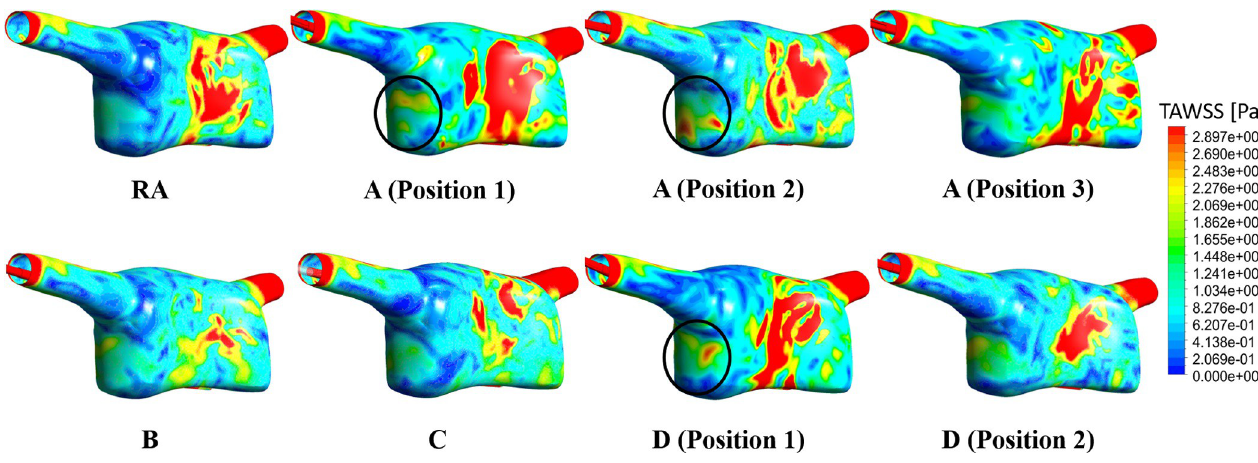
Fig 14. Time-averaged WSS [Pa] for the whole RA